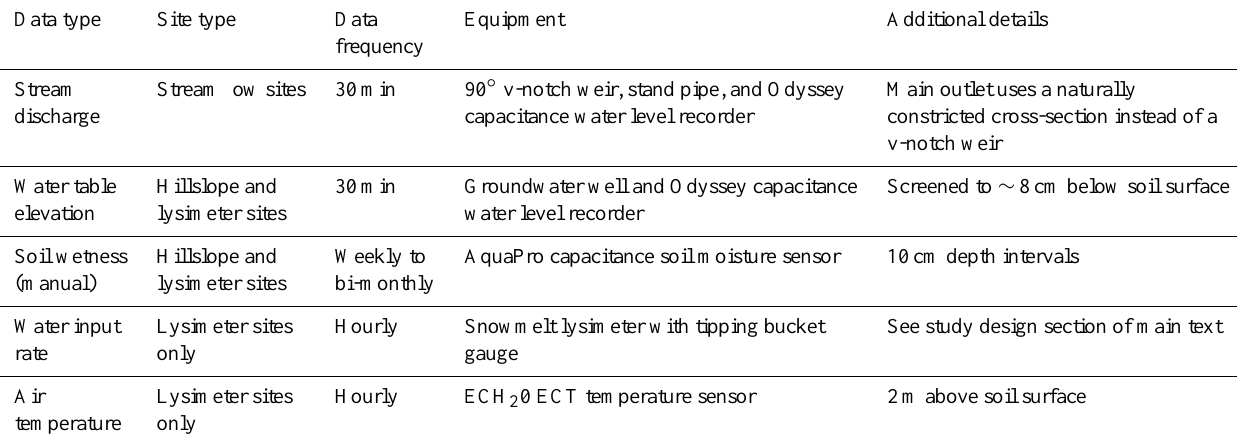
Table 1. Data collection infrastructure at the streamflow, hillslope, and lysimeter